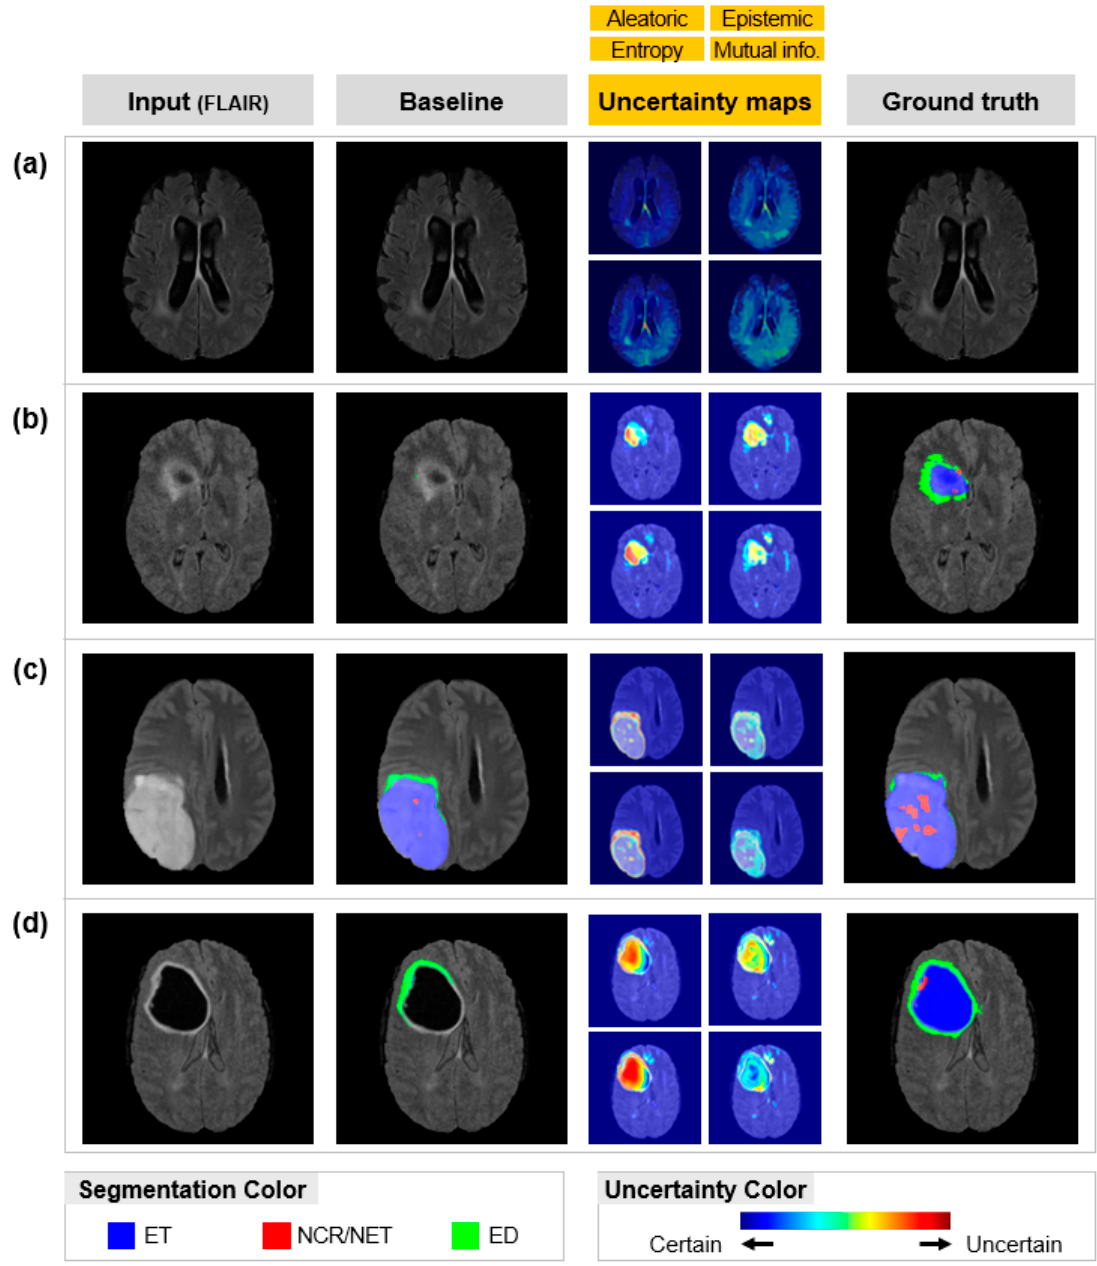
Figure 4. Uncertainty quantification results: Automated segmentation results by baseline model, corresponding uncertainty maps, image, and manual segmentation by experienced neurologists (ground truth). Each scan is from a different patient. The color code of the segmentation map and uncertainty map is described below. Red in the uncertainty map means an uncertain predictive area, and blue means a certain predictive area. ET = enhancing tumor; NCR/NET = necrotic and non-enhancing tumor; ED = peritumoral edema. ( a ) Totally correct prediction and UMs. ( b ) Totally incorrect prediction and UMs. ( c ) Slightly incorrect prediction and UMs. ( d ) Moderately incorrect prediction and UMs.